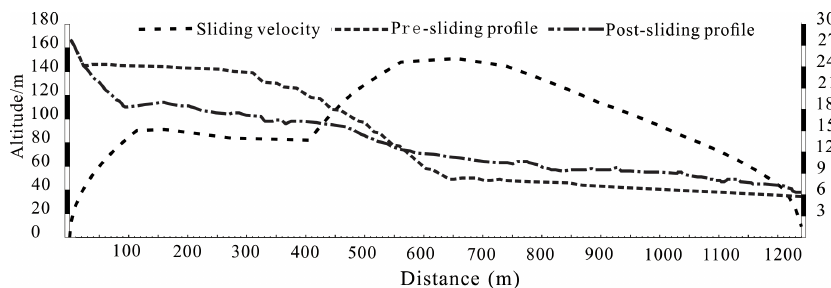
Figure 17. The estimated travel velocity profile along profile line 1-1’ with pre-/post-sliding landform.